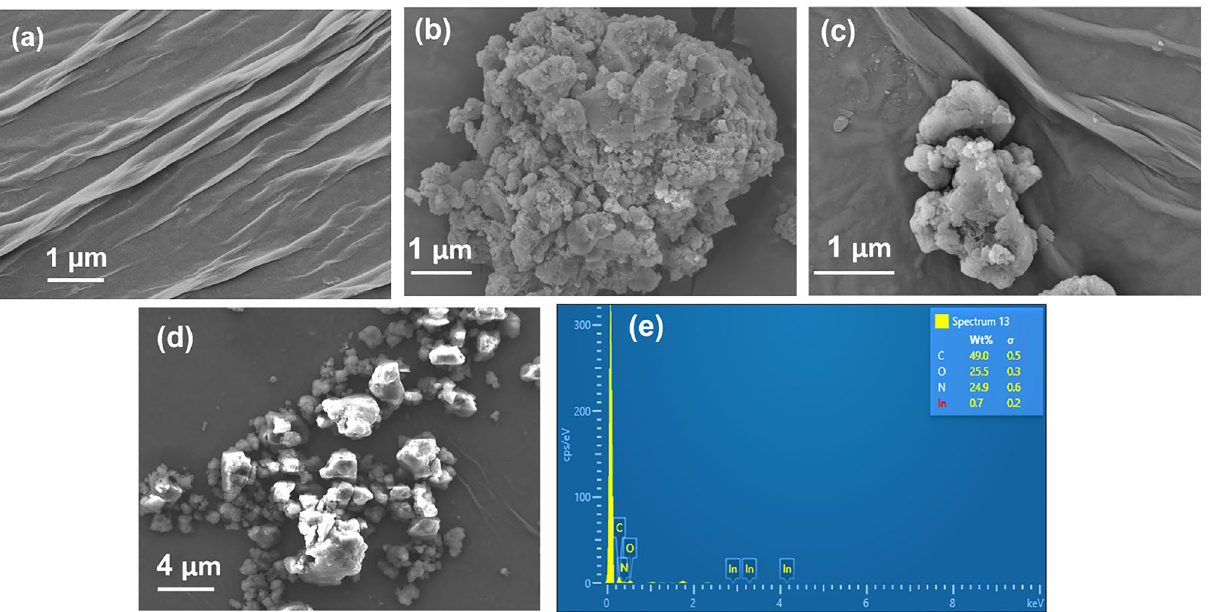
Figure 4. FESEM image of ( a ) rGO, ( b ) PhPTz, ( c ) PhPTz/rGO, ( d ) anti-CEA/PhPTz/rGO, ( e ) EDS spectra of